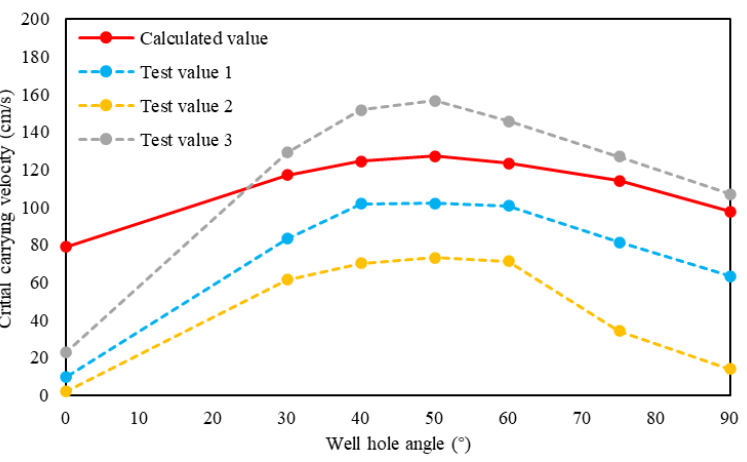
Figure 6. Relationship between critical sulfur-carrying velocity and inclination angle.